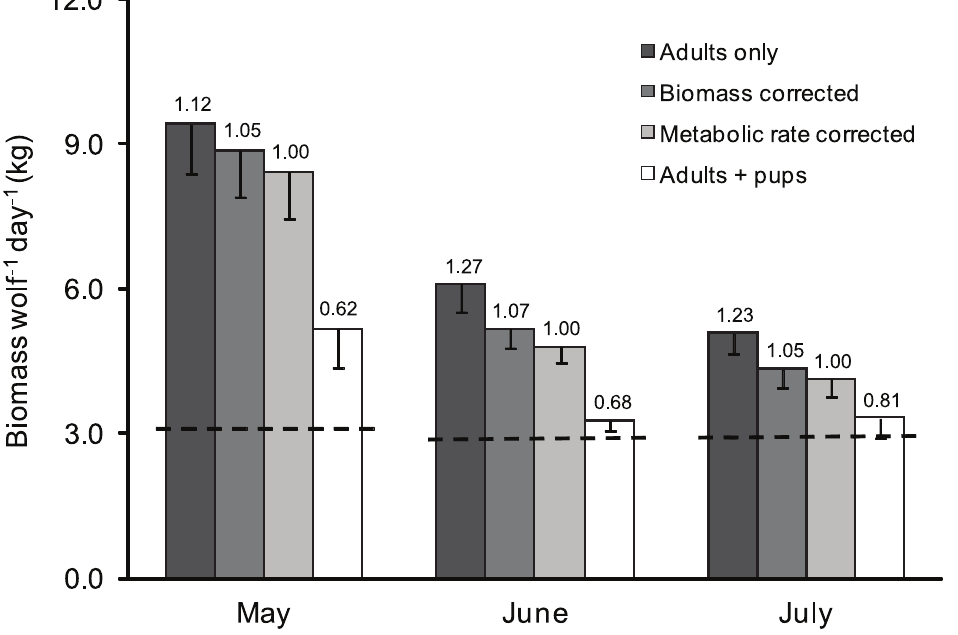
Figure 4. Estimates of per capita rates of prey acquisition based on different methods for determining pack size. The number above each bar represents the rate in proportion to the metabolic corrected rate. Vertical bars represent the standard error. The dashed lines represent the estimated minimum daily energetic requirement (3.84 and 3.59 kg wolf 2 1 day 2 1 in May and June/July, respectively) for adult wolves in our study area [37].